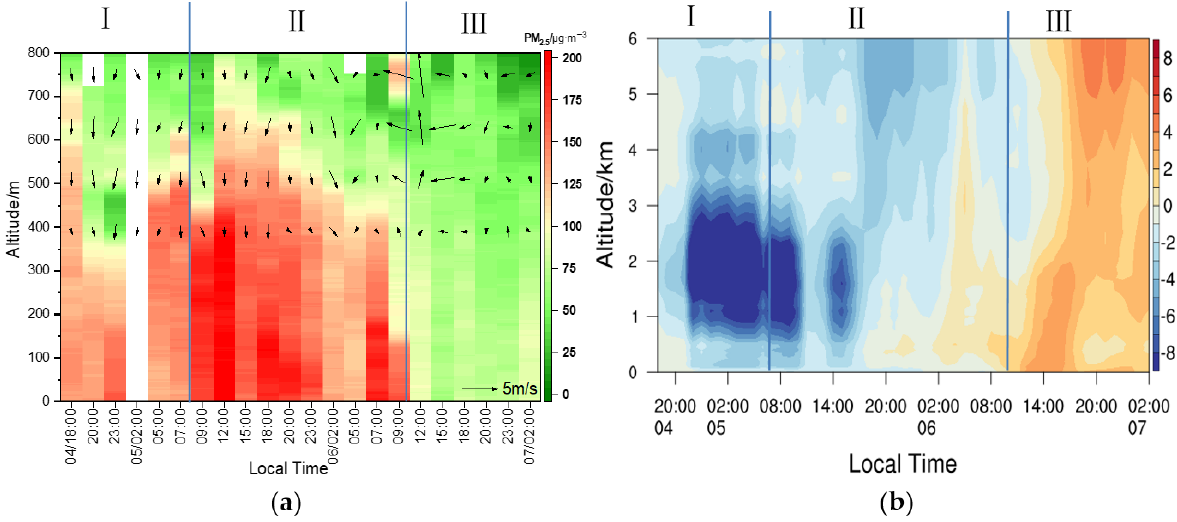
Figure 3. ( a ) The time–height profile of PM 2.5 concentration detected by the unmanned aerial vehicle (UAV), the near boundary horizontal wind field detected by a wind profiler radar, and the ( b ) 24 h temperature variations at 0–6 km height detected by microwave radiometers at Xianning station from 18:00 LST on 4 January to 02:00 LST on 7 January, 2019.